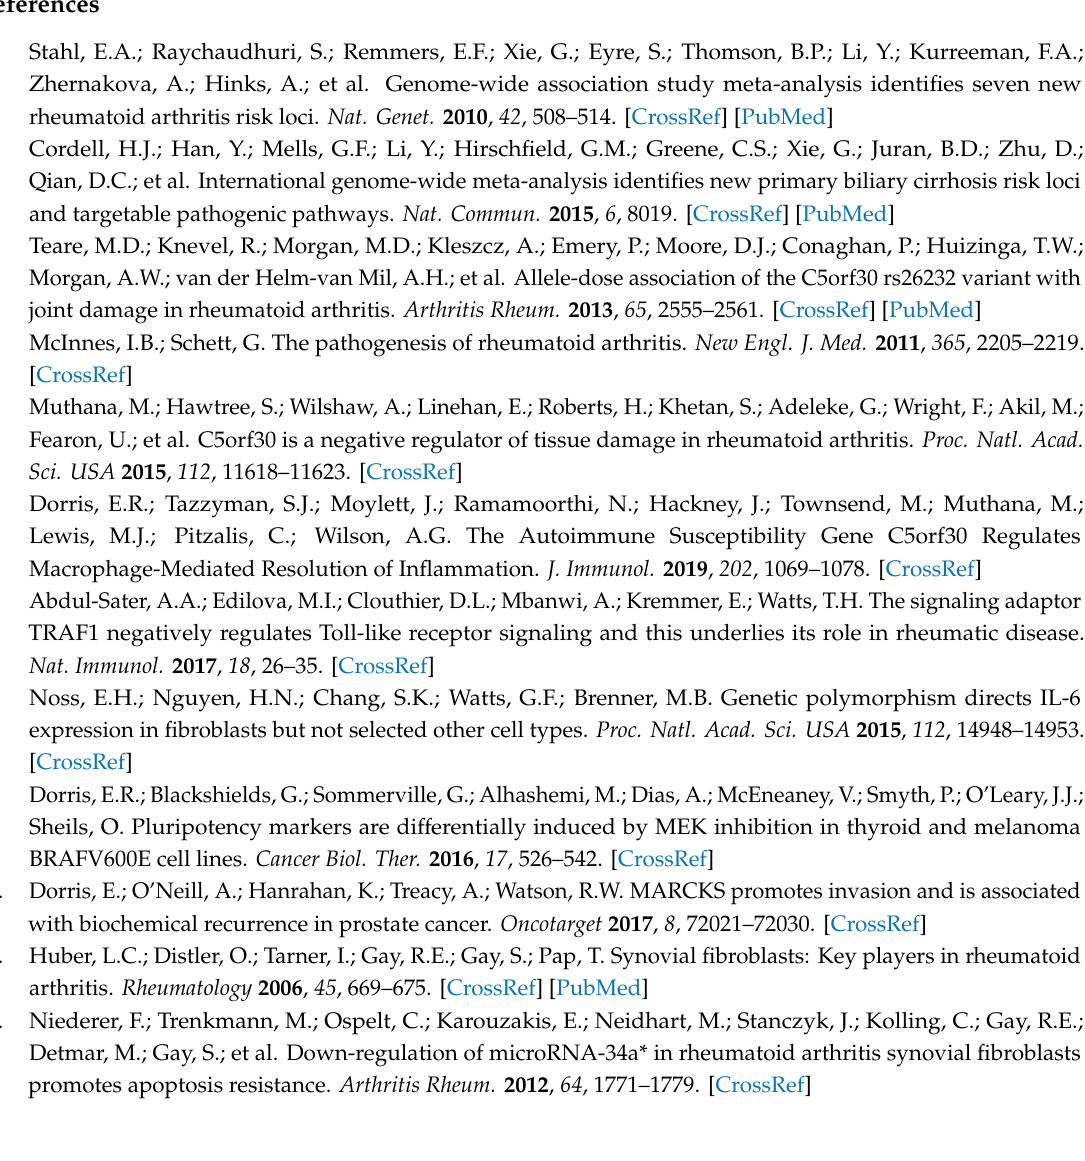
Figure S1: rs26232 genotype is not associated with metalloproteases or macrophage chemokines by RASFs. Figure S2: rs26232 genotype is not associated with expression of adhesion markers or cathepsin K. Table S1: Sequences of oligonucleotide primers used in RT-PCR (5 (cid:48) –3 (cid:48) ). Table S2: TaqMan Assay IDs used in